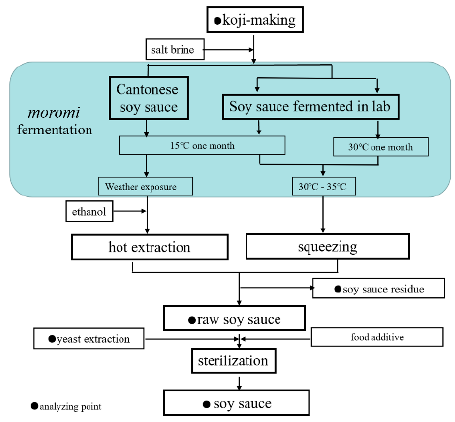
Figure 4. The diagram of soy sauce producing scheme (The arginine, citrulline, and ornithine contents of yeast extraction in this study are 64.71 mg/g, 0 mg/g and 10.89 mg/g,